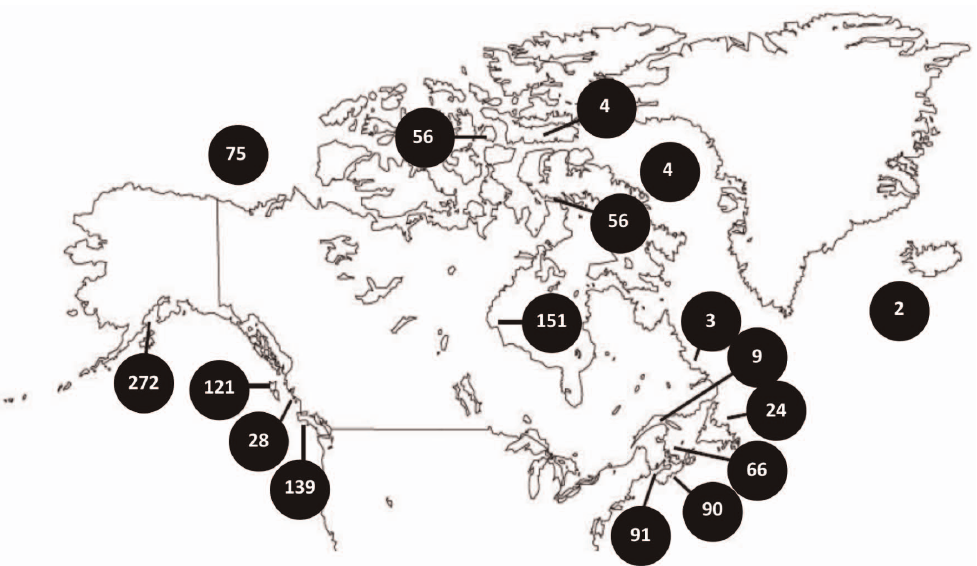
Figure 1. Collection sites. Sampling locations and the number of specimens examined in this study. Only specimens that generated a sequence are shown. Twenty-three sequences obtained from GenBank are not included as they lack locality information.